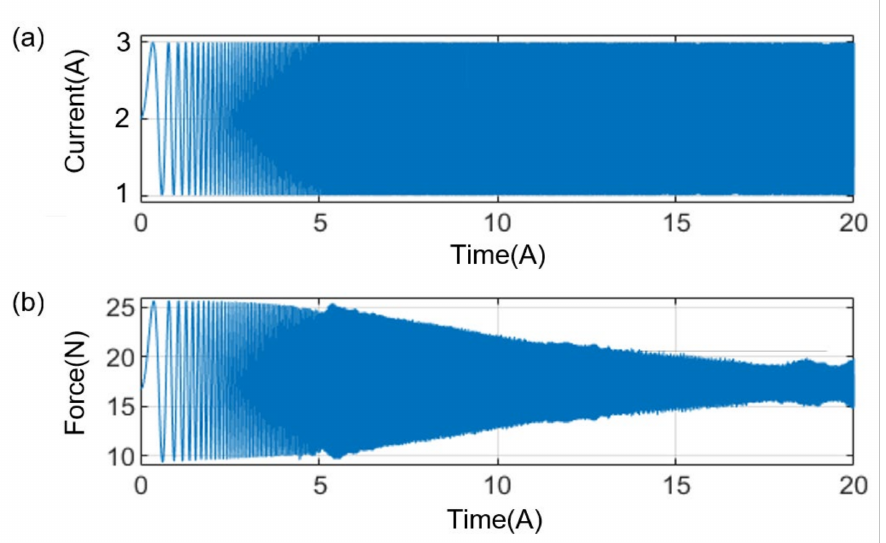
Figure 4. System identification of the grinding tool: ( a ) Chirp sine as the input and ( b ) force as the